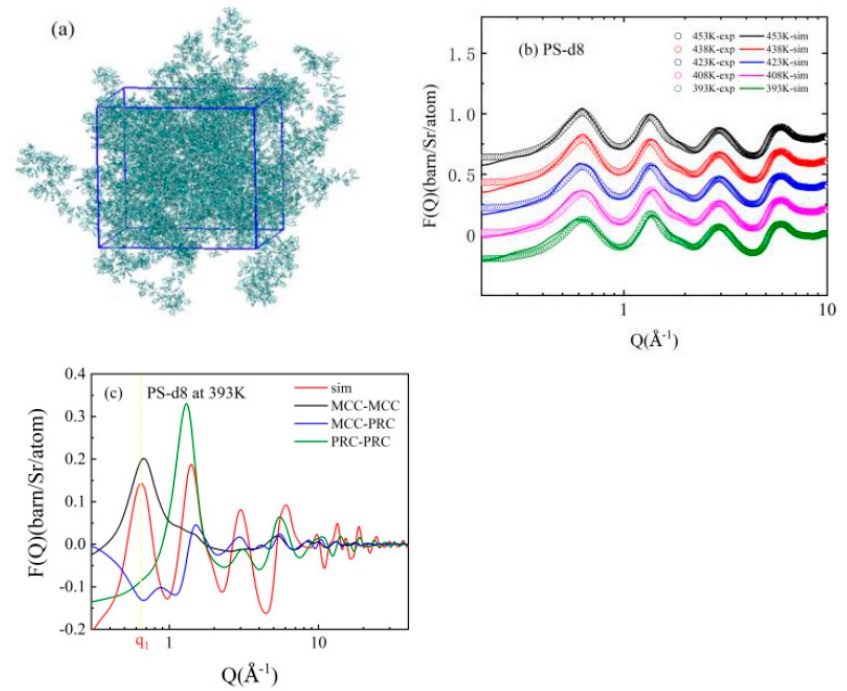
Figure 1. Neutron total scattering and all-atom simulation; ( a ) 3D atomic structure of PS at 393 K; ( b ) neutron total scattering profiles of PS-d8 at different temperatures and the Fourier transform from ( a ); ( c ) the decomposition of q 1 peak of PS-d8 at 393K, the yellow dash lines were used to guide the eye.